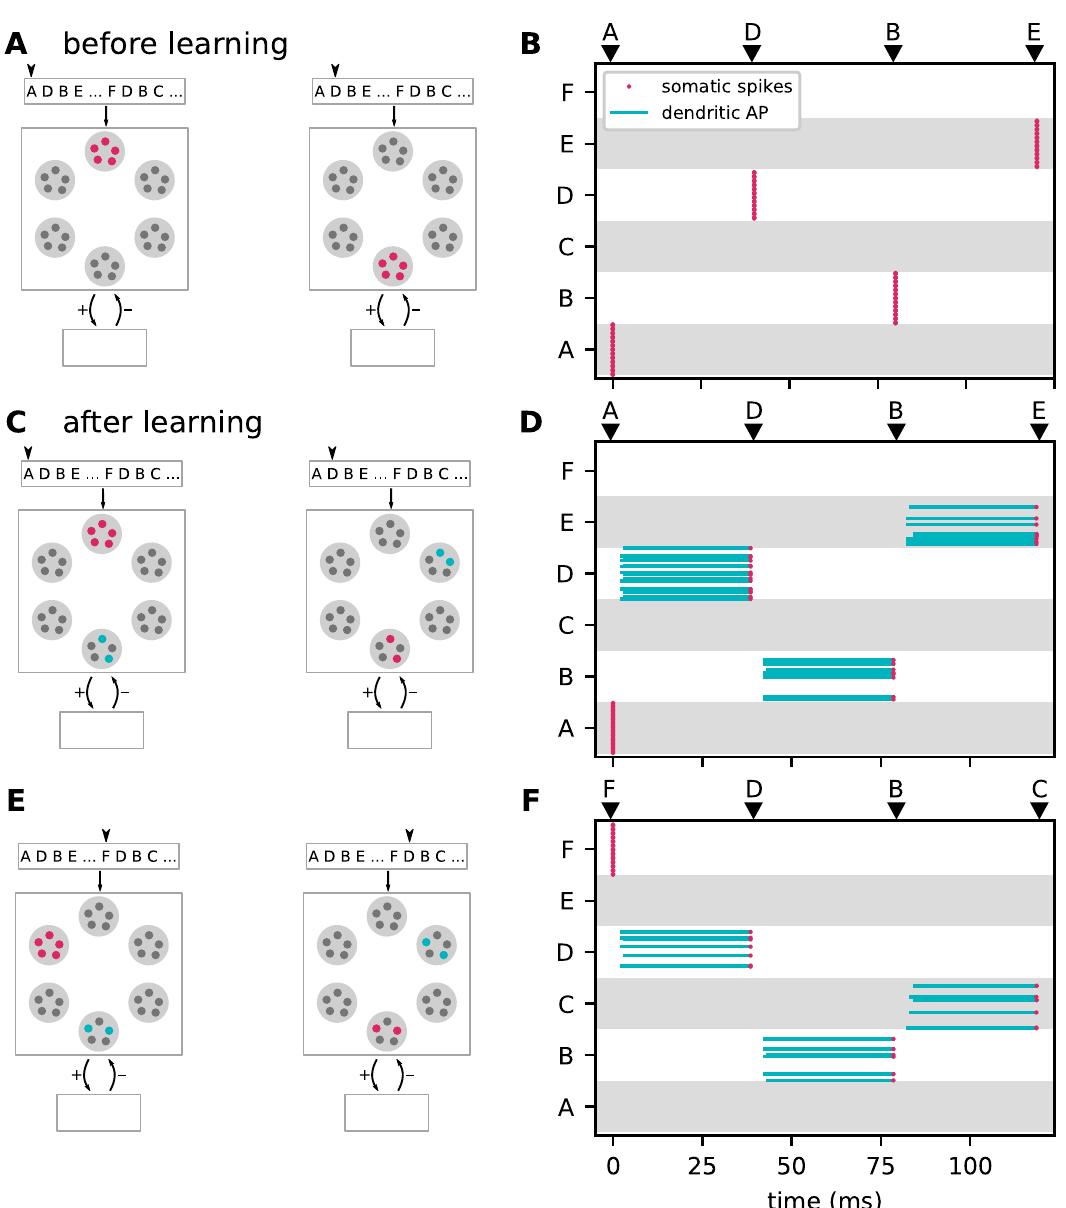
Fig 6. Context specific predictions. Sketches (left column) and raster plots of network activity (right column) before (top row) and after learning of the two sequences {A, D, B, E} and {F, D, B, C} (middle and bottom rows). In the left column, large light gray circles depict the excitatory subpopulations (same arrangement as in Fig 2). Red, blue and gray circles mark active, predictive and silent neurons, respectively. In the right column, red dots and blue lines mark somatic spikes and dAP plateaus, respectively. Type and timing of presented stimuli are depicted by black arrows. A,B) Snapshots of network activity upon subsequent presentation of the sequence elements “A” and “D” (panel A), and network activity in response to presentation of the entire sequence {A, D, B, E} (panel B) before learning. All neurons in the stimulated subpopulations become active. C,D) Same as panels A and B, but after learning. Presenting the first element “A” causes all neurons in the corresponding subpopulations to fire. Activation of these neurons triggers dAPs (predictions) in a subset of neurons representing the subsequent element “D”. When the next element “D” is presented, only these predictive neurons become active, leading to predictions in the subpopulation representing the subsequent subpopulation (“B”), etc. E,F) Same as panels C and D, but for sequence {F, D, B, C}. The subsets of neurons representing “D” and “B” activated during sequences {A, D, B, E} and {F, D, B, C} are distinct, i.e., context specific. For clarity, panels B, D, and F show only a fraction of excitatory neurons